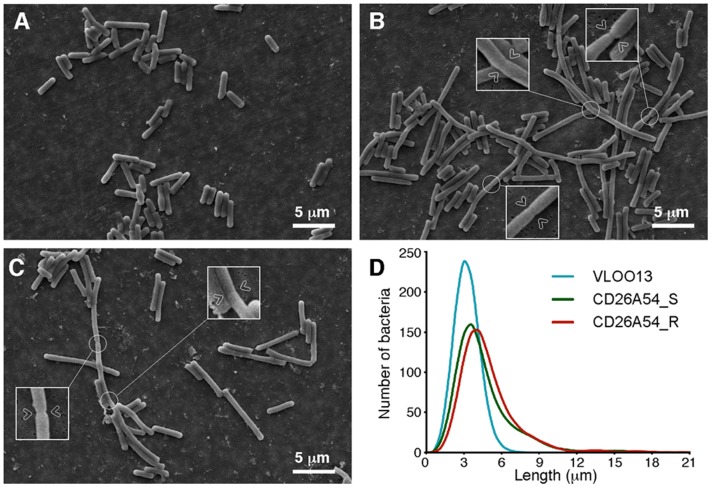
Scanning electron microscopy of C. difficile.SEM images of VLOO13 (A), CD26A54_S (B) and CD26A54_R (C). (D) Histograms of calculated bacterial length are presented; they demonstrate the cell length variation that exists across the three C. difficile specimens that were imaged by SEM. The insets with arrows in panels (B, C) highlight the septum which partially forms between adjacent cells. Cell separation appears to be impaired resulting in the longer phenotype.